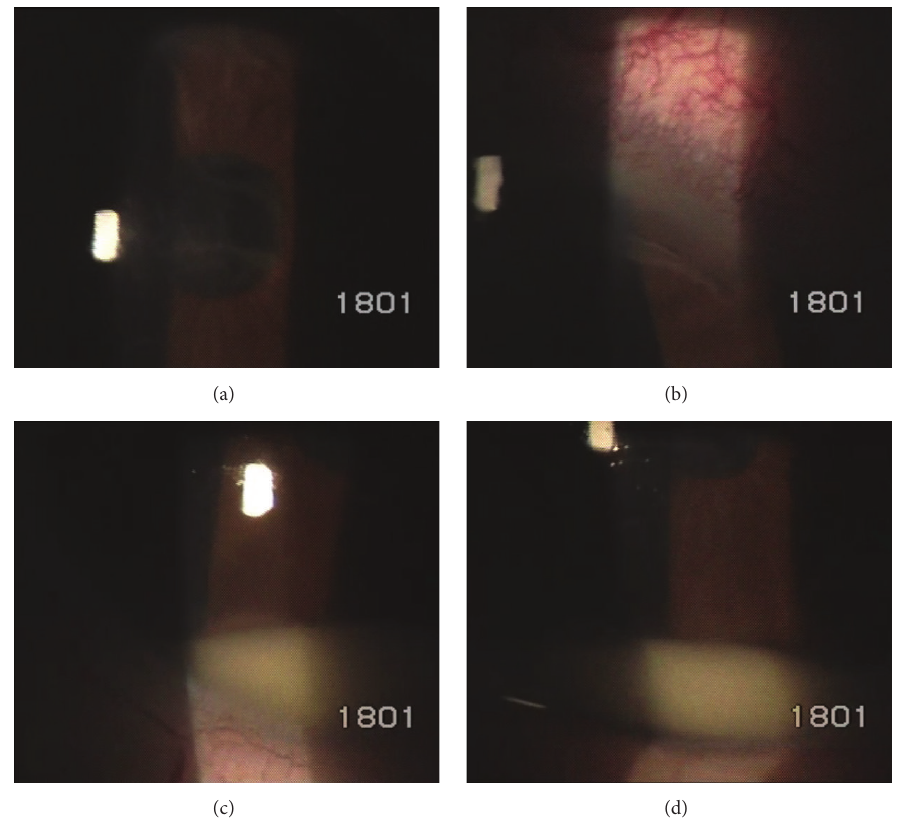
Figure 1: Ciliary injection, anterior chamber reaction with fibrin, and membrane formation (a and b). Hypopyon relapse (c and d).